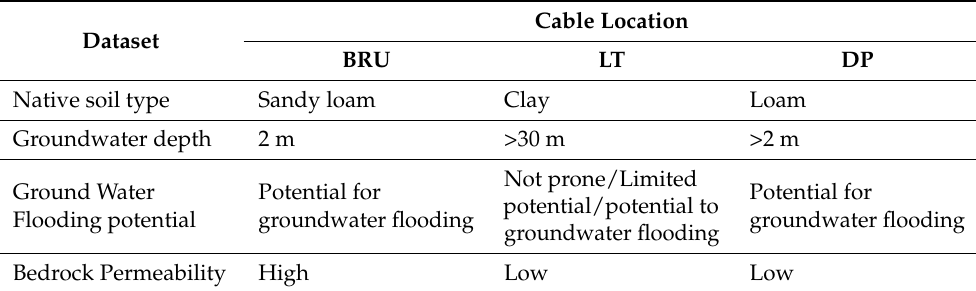
Table 3. Native materials at areas of